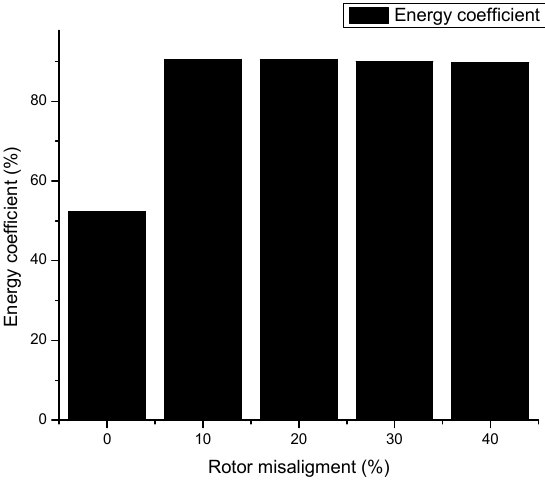
Figure 10. The graph of determining the energy coefficient and rotor misalignment.